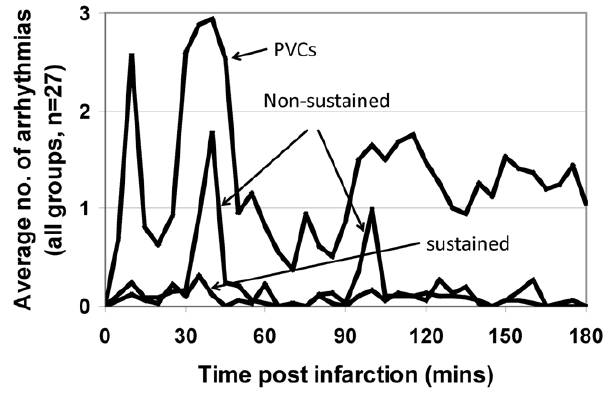
Figure 1. Time course of arrhythmias. Graphs of the average number of arrhythmias per animal in each 5 minute time period over the duration of each experiment for each of the three groups of arrhythmias: PVCs (including single and multiple PVCs and alternating rhythms such as bigeminy and trigeminy), non-sustained ventricular tachycardia and ventricular fibrillation (lasting for more than 1 s but self-terminating within 15 s of commencement), and sustained ventricular tachycardia and ventricular fibrillation (lasting for more than 15 s and requiring cardioversion or defibrillation). Note that the number of PVCs shown is 1/10 th of the actual number of PVCs recorded (to enable display on the same graph). The periods of peak arrhythmia activity can be seen to extend between 0 and 20 mins, 20 and 50 mins, and 50 and 180 mins, corresponding to Phase 1a, Phase 1b and Phase 2 arrhythmias